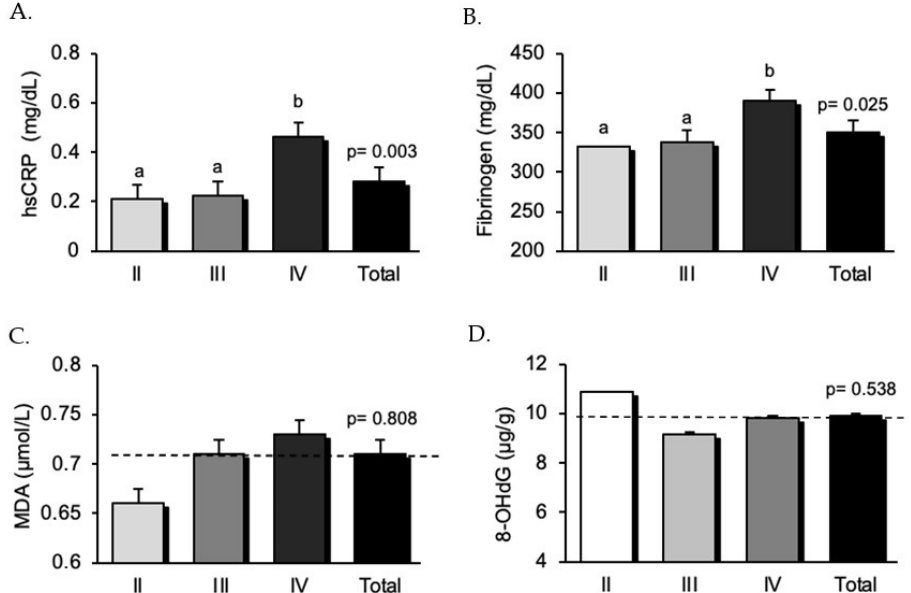
Figure 1. Study population inflammatory and oxidative stress parameters according to periodontitis stages. Serum high-sensitivity C-reactive protein ( A ), fibrinogen ( B ) and malondialdehyde ( C ), and urine 8-hydroxy-2′-deoxyguanosine ( D ) levels.